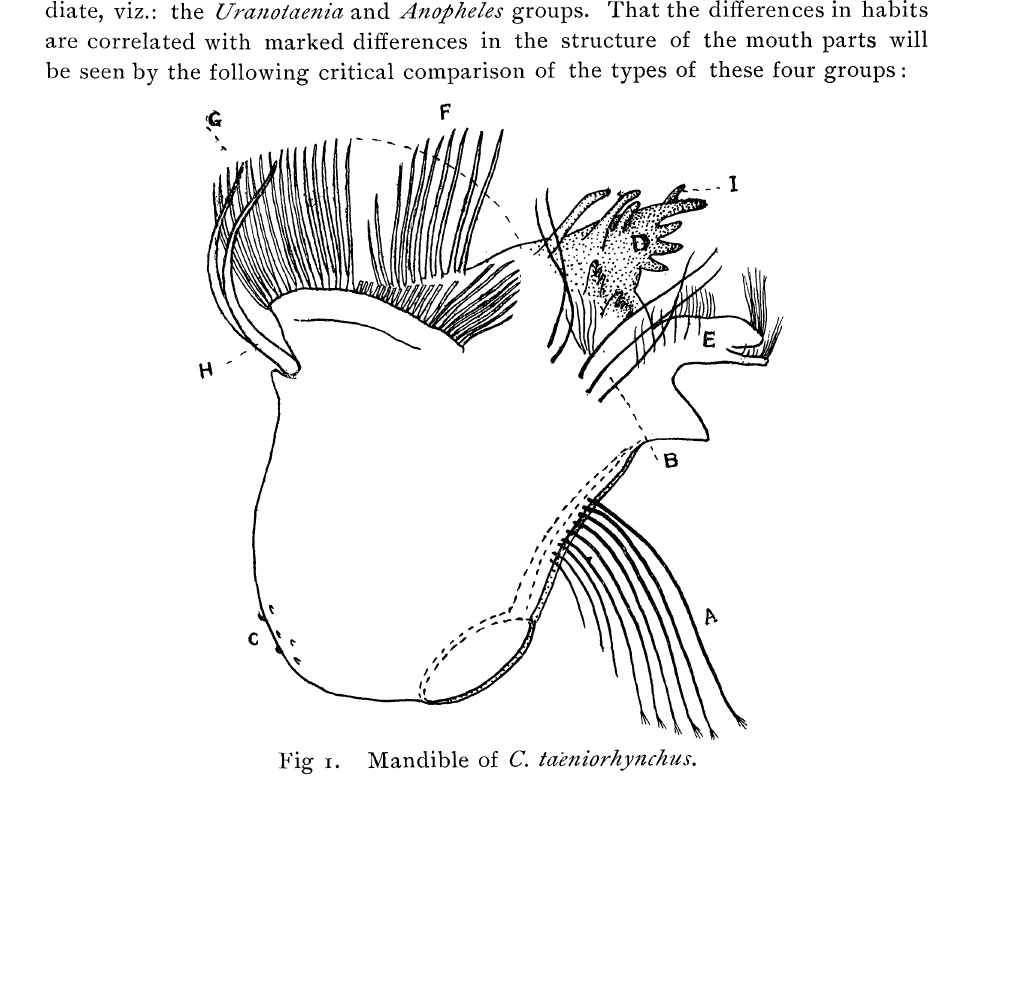
,. Mandible of C. Fig